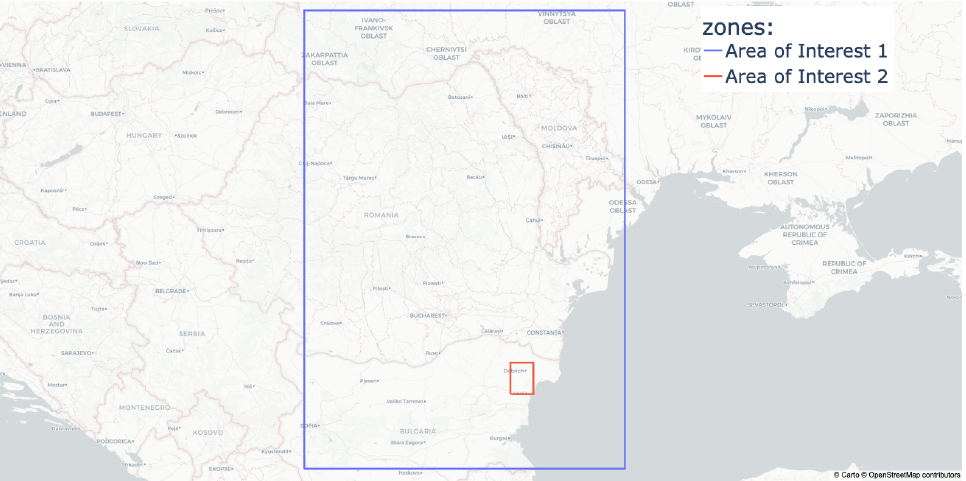
Figure 1. Areas of interest AoI-1 (blue box) and AoI-2 (red